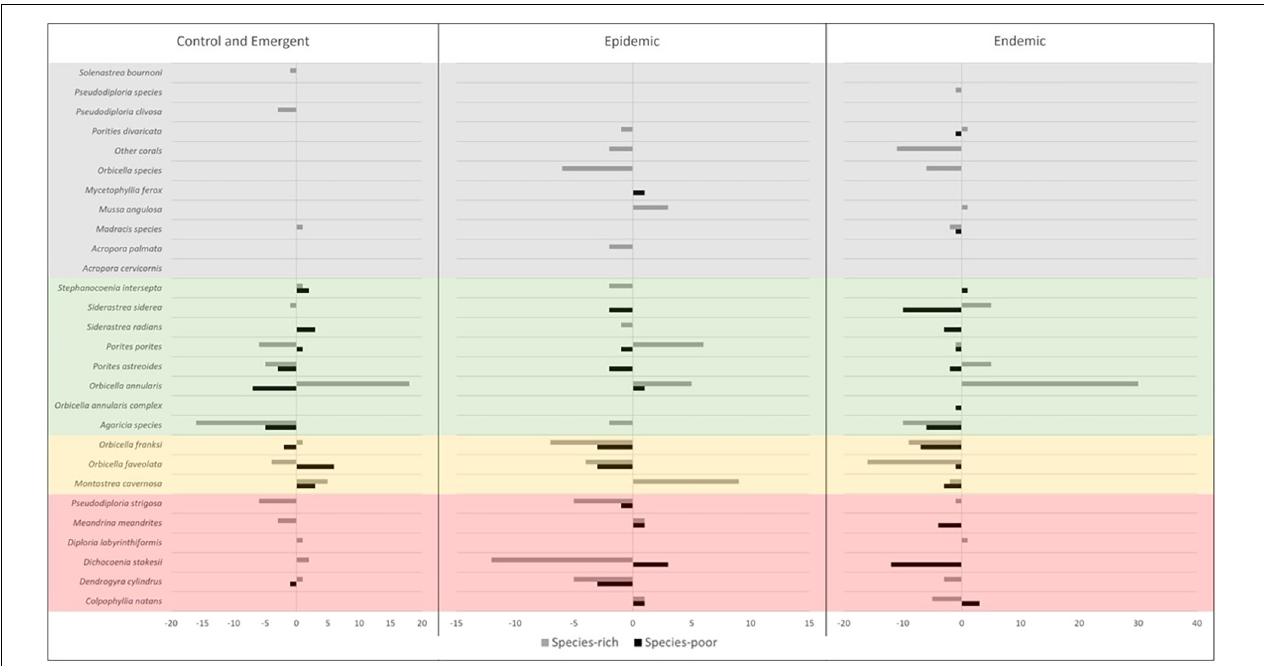
FIGURE 7 | Absolute change in coral cover between pre- and post- outbreak surveys for each species at species-rich ( ≥ 12 spp.) and species-poor ( < 12 spp.) sites by zone. Species susceptibility classifications are shown in the color boxes and based on the results of this study (Red = high susceptibility, Yellow = intermediate susceptibility, Green = low susceptibility, Gray = unknown susceptibility).